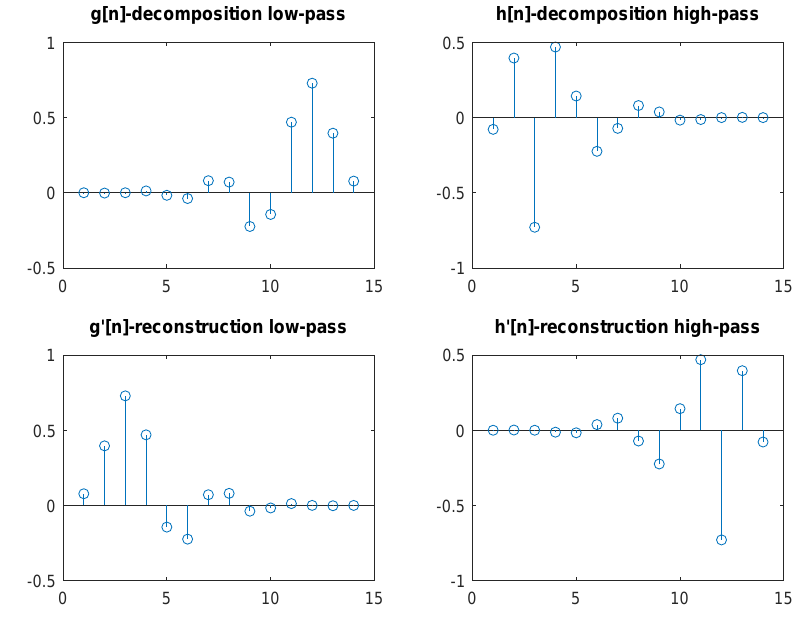
Figure 5. Transform filters of the wavelet type